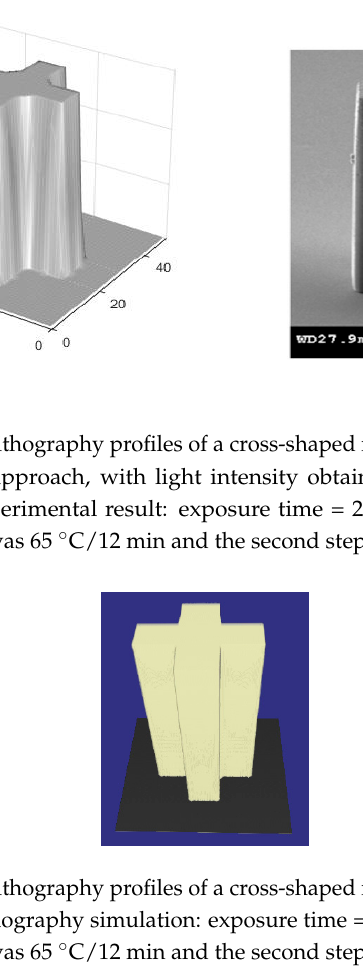
Figure 8. Three-dimensional lithography profiles of a cross-shaped mask with perpendicular incidence by using a comprehensive lithography simulation: exposure time = 250 s, development time = 12 min. The first step PEB condition was 65 °C/12 min and the second step PEB condition was 95 °C/40 min.